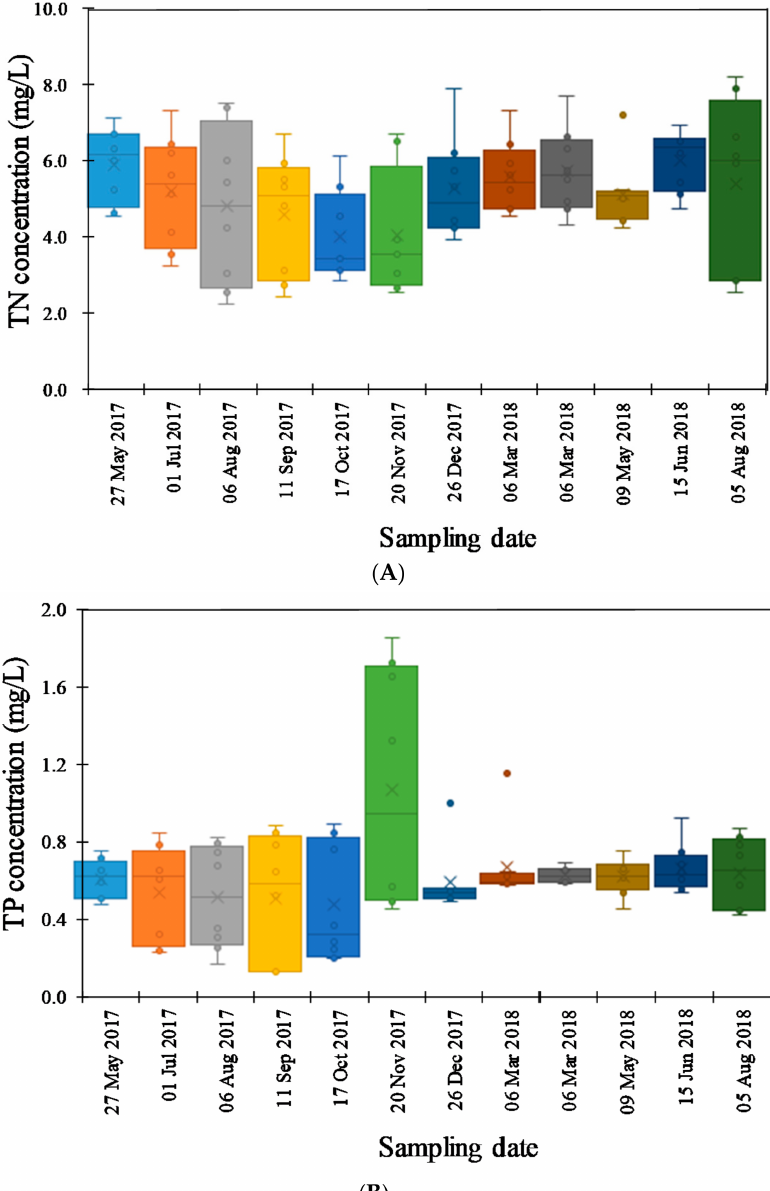
Figure 3. Variation of ( A ) total nitrogen (TN) and ( B ) total phosphorus (TP) concentrations throughout the water column in the Sabalan dam reservoir during the sampling